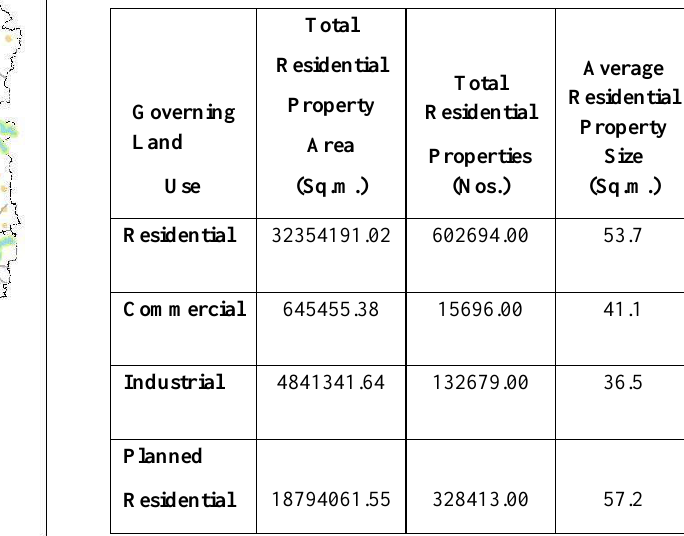
Table 4: Average Unit Area of Household with governing land